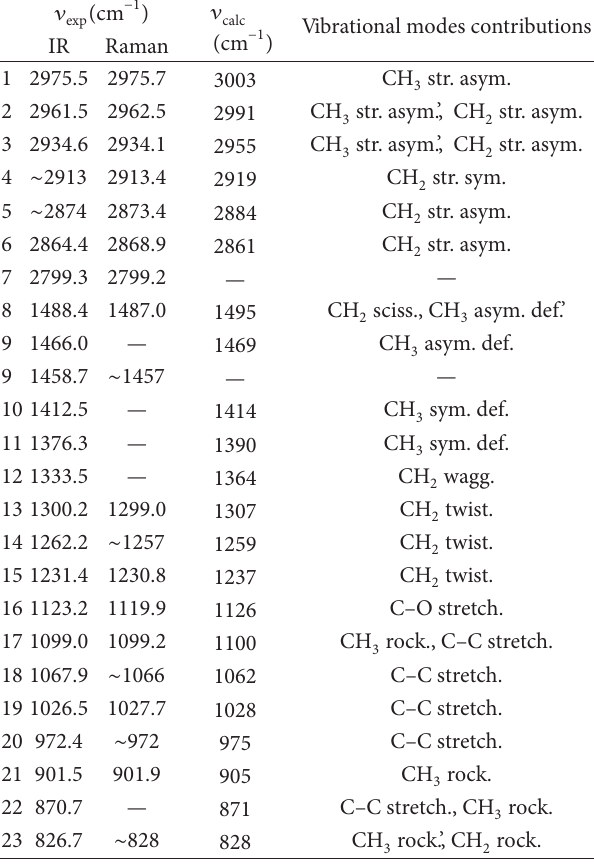
Calculated Experimental F8:CalculatedandexperimentalspectraofNBEEinthelower MIR range (1800–560cm